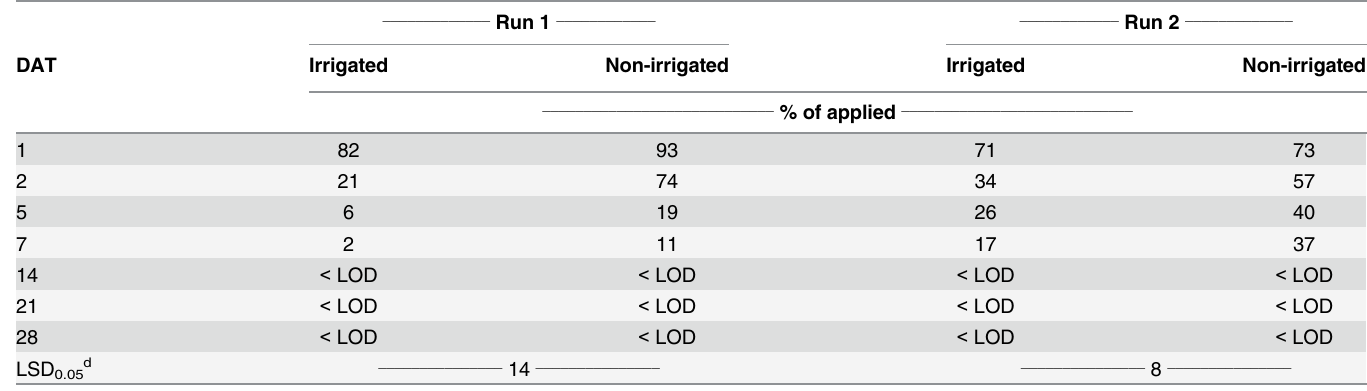
a Abbreviations: DAT, d after treatment (2,4-D); LOD, limit of detection. b 0.3 cm H 2 O irrigation applied at 1 DAT (13:00 EST) after sampling.